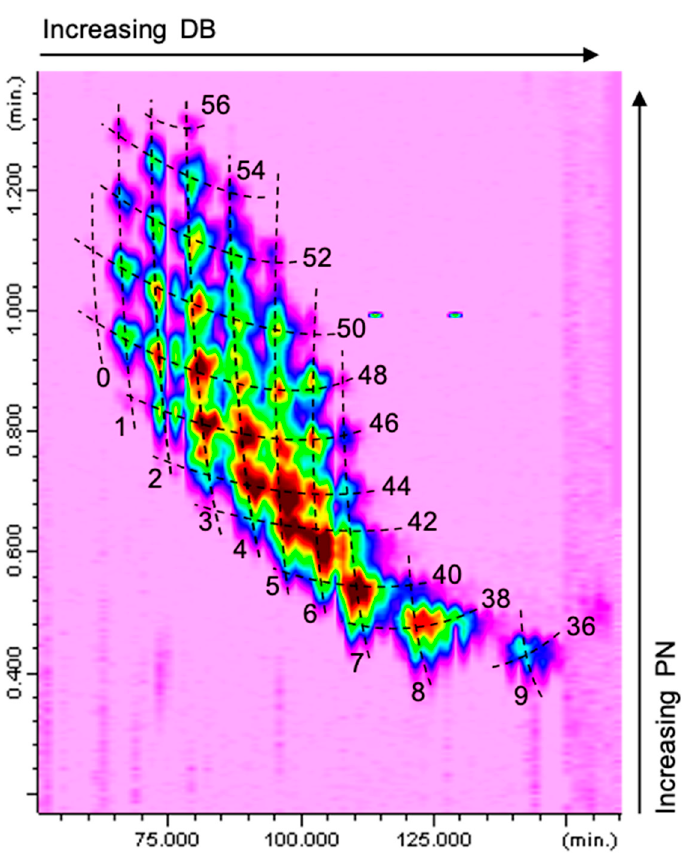
Figure 2. Ag + -LC×NARP-UHPLC separation of a borage seed oil (total ion chromatogram obtained Figure 2. Ag + -LC × NARP-UHPLC separation of a borage seed oil (total ion chromatogram obtained by APCI-MS in positive ion mode). by APCI-MS in positive ion